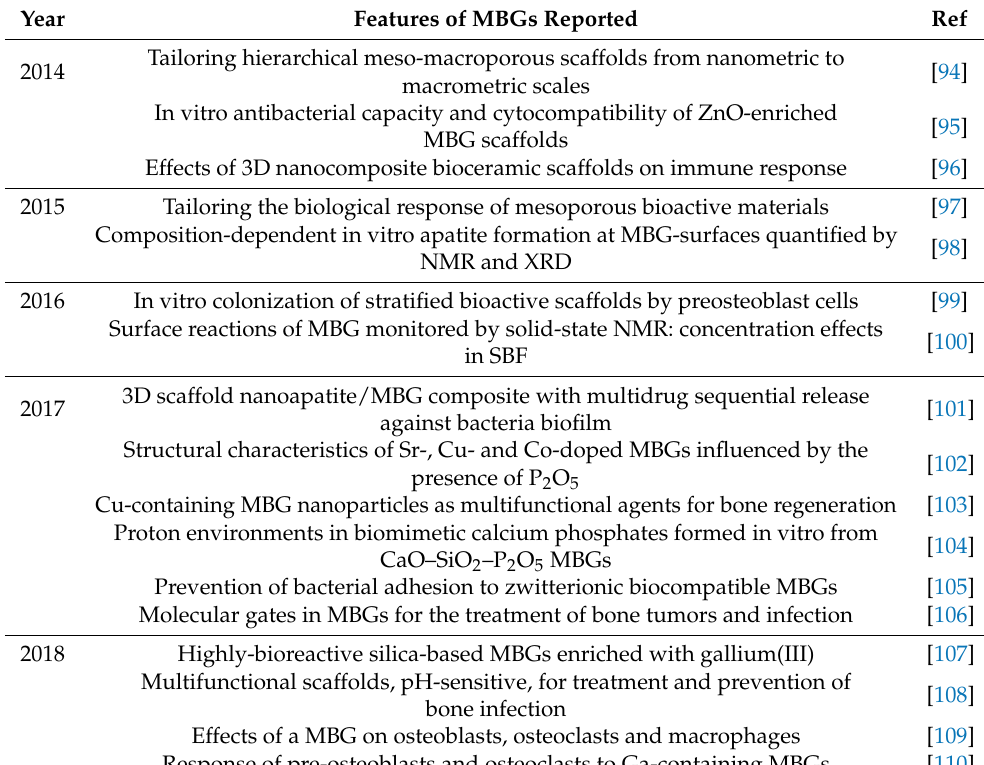
Table 1. Cont. Year Features of MBGs